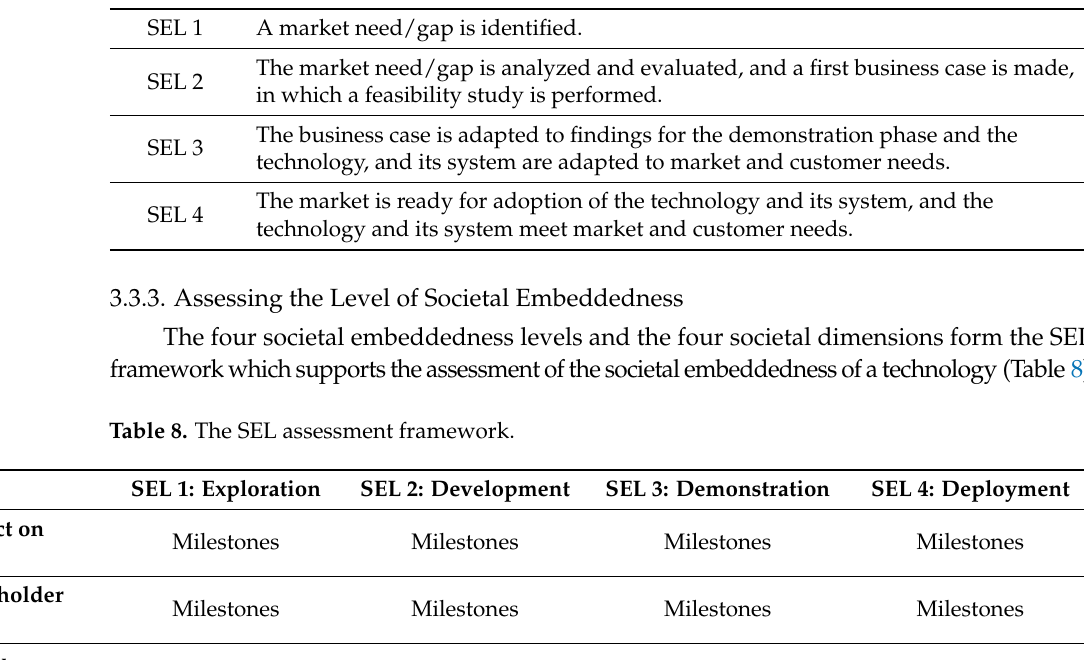
Table 7. Dimension 4: market and financial resources.